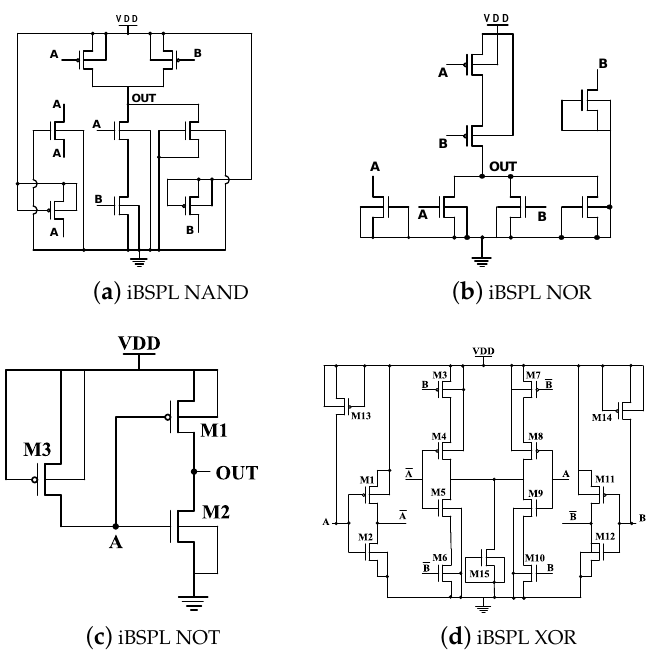
Figure 8. iBSPL gates in 40nm. Table 3. Number and size of TCBs added to each gate to achieve a balanced static power